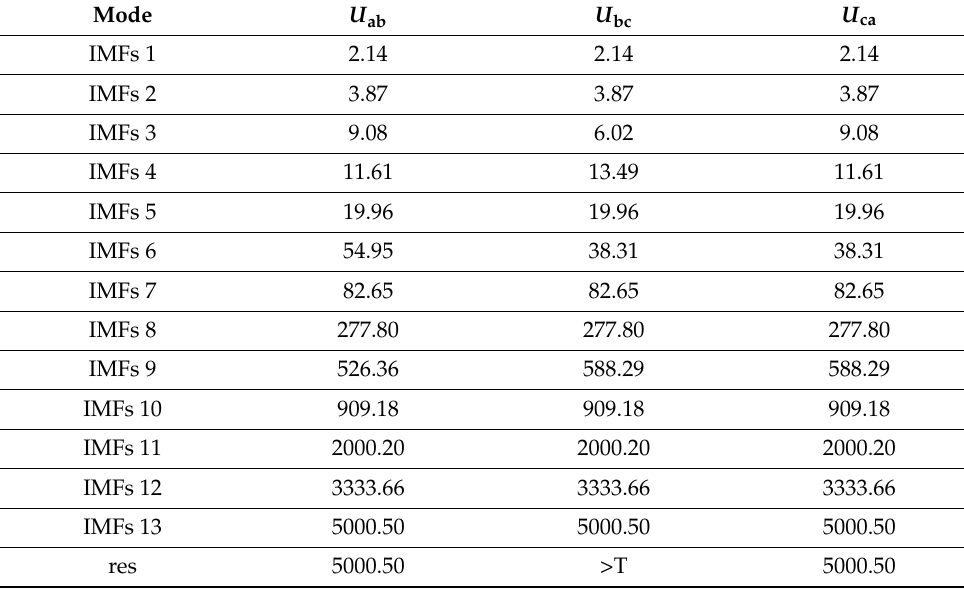
Table 3. The timescales of the common modes extracted by MEMD.